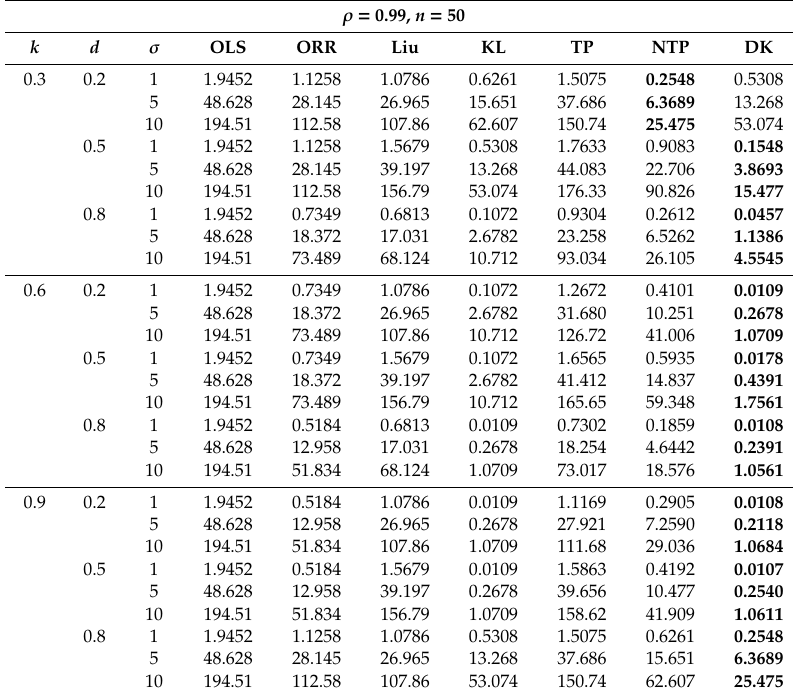
Table 2. Estimated MSE for OLS, ORR, Liu, KL, TP, NTP, and DK. ρ = 0.99, n =